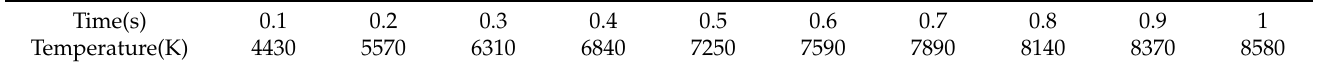
Table 2. Simulation data of arc center temperature when pantograph gap is 1 mm.